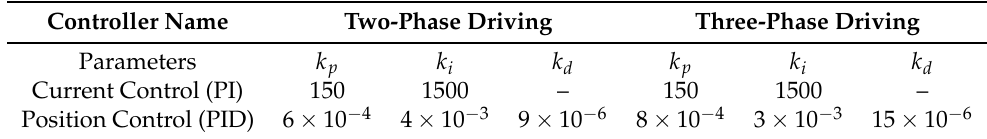
Table 2. Implemented controllers parameters